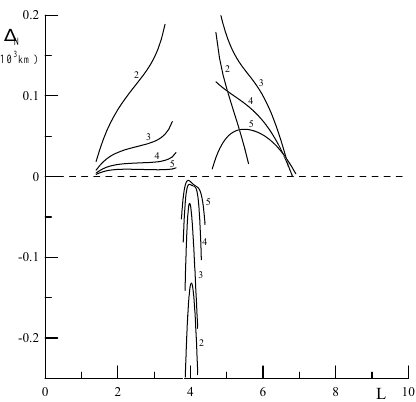
Fig. 5. Dependency of resonant magnetic surface splitting 1 N (equatorial distance between poloidal and toroidal resonant sur- faces) on magnetic shell parameter L for the longitudinal harmonics N = 2 , 3 , 4 , 5. In the range of magnetic shells studied, 1 N practi- cally does not depend on the azimuthal wave number m .